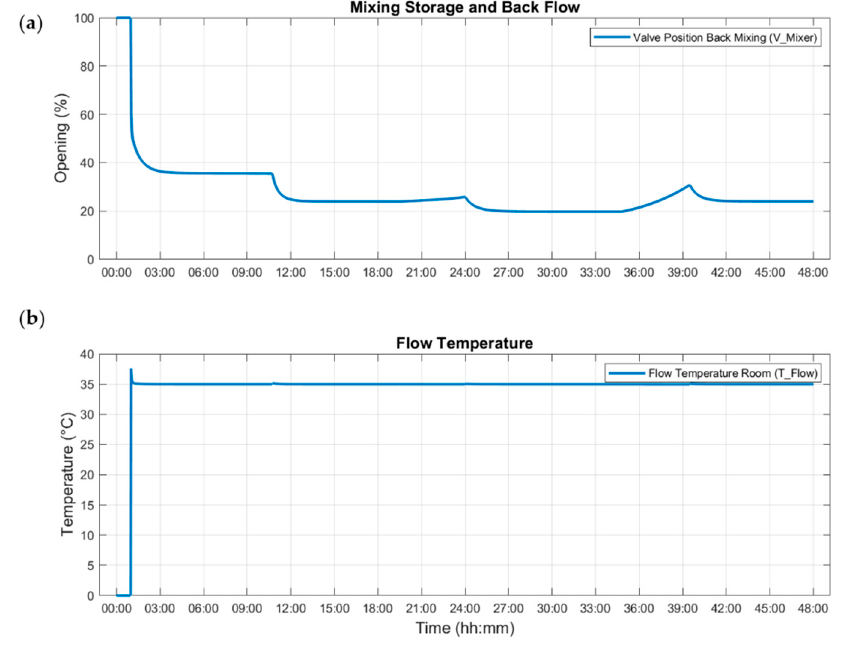
Figure 8. Supply temperature and back-mixing valve position for room temperature controlling. ( a ) the opening of the mixing valve to achieve the desired flow temperature; ( b ) the mixed flow temperature.